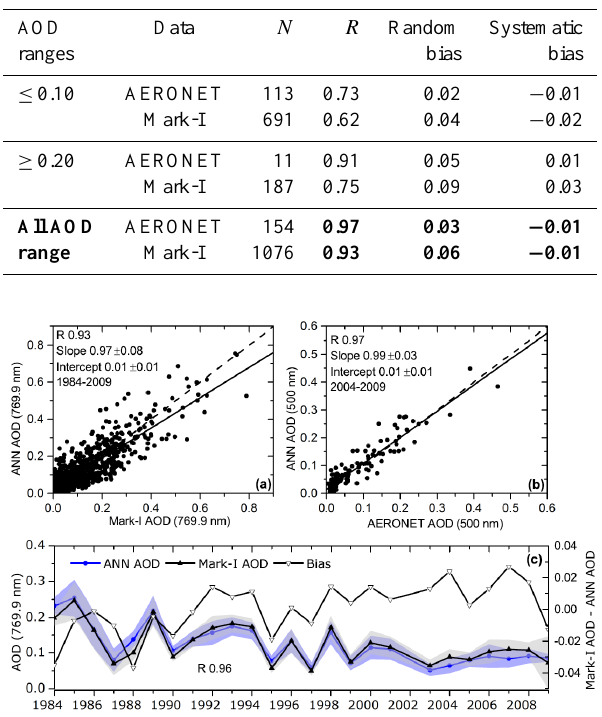
Figure 5. Scatterplot of ANN AOD estimates vs. (a) daily Mark- I AOD at 769.9nm for all the cloud-free days (oktas = 0) and (b) daily AERONET AOD at 500nm for the periods 1984–2009 and 2004–2009, respectively. The black solid lines are the least- square fits and the dotted lines are the diagonals. The least-square fit parameters are shown in the legend (Pearson correlation coeffi- cient, R , slope and intercept). (c) Time series of monthly medians of Mark-I AOD and ANN AOD estimates in July (on the left axis) and time series of the differences between these AOD values (on the right axis). Shadings show the range of ± 1SEM (standard error of the monthly